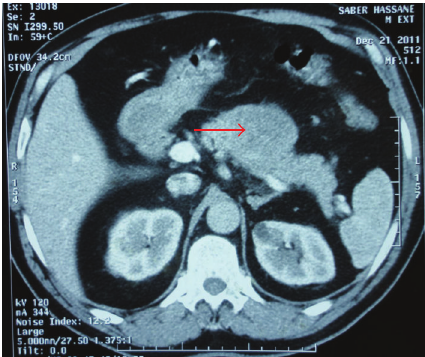
Figure 1: Laterocervical lymphadenopathy biopsy slide: histologi- cal features at lower magnification view (x10): proliferation of mall round tumor cells arranged in di ff use nappe with presence of some rosettes. Vascularization is spindly and endocrine type.